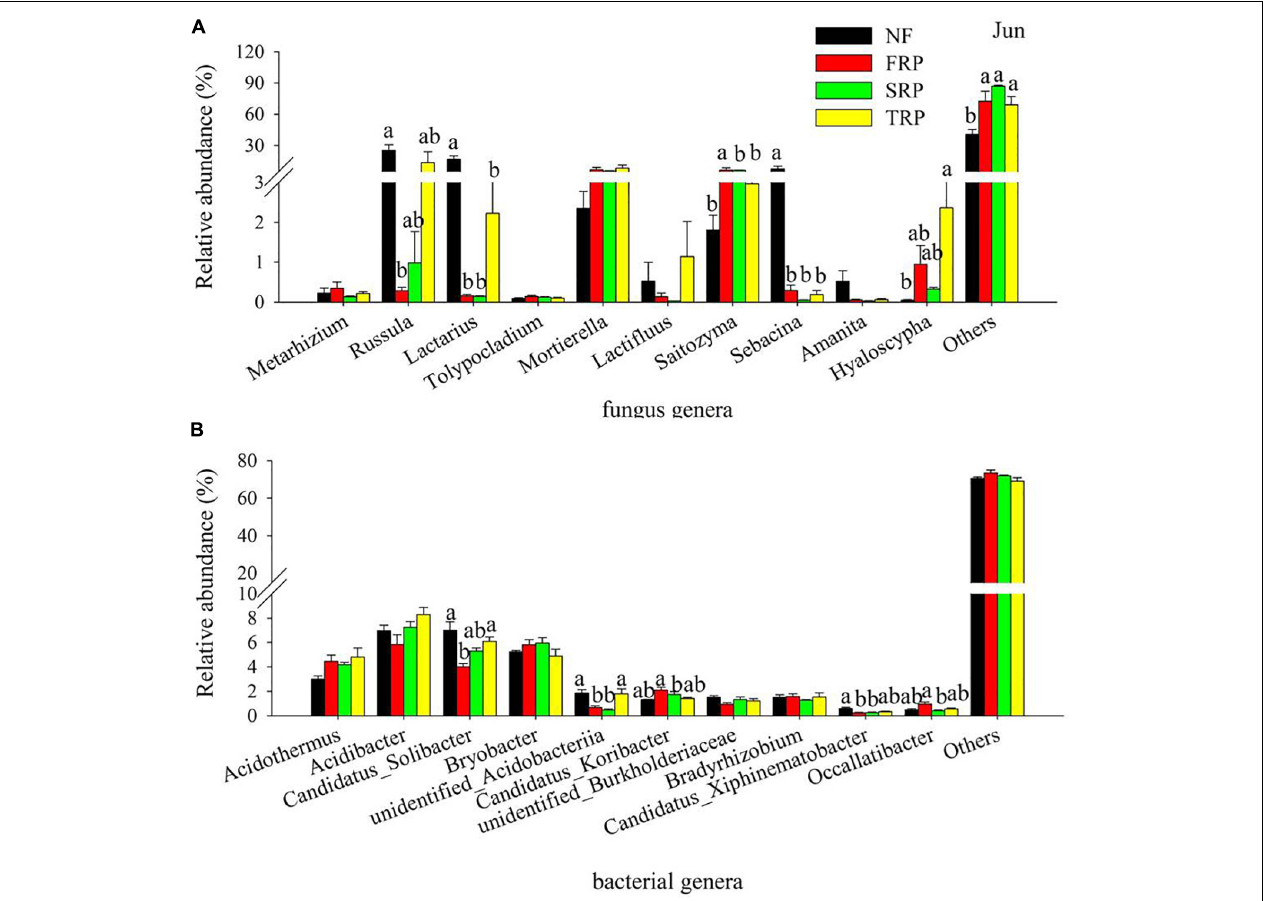
FIGURE 2 | Relative abundance of the most abundant fungal (A) and bacterial (B) groups in different plantations in June at the genus level. Others represented unclassified groups. Data are means ± standard error ( n = 4). Significant differences are indicated with distinct letters. NF, natural forest; FRP, first rotation plantation; SRP, second rotation plantation; TRP, third rotation